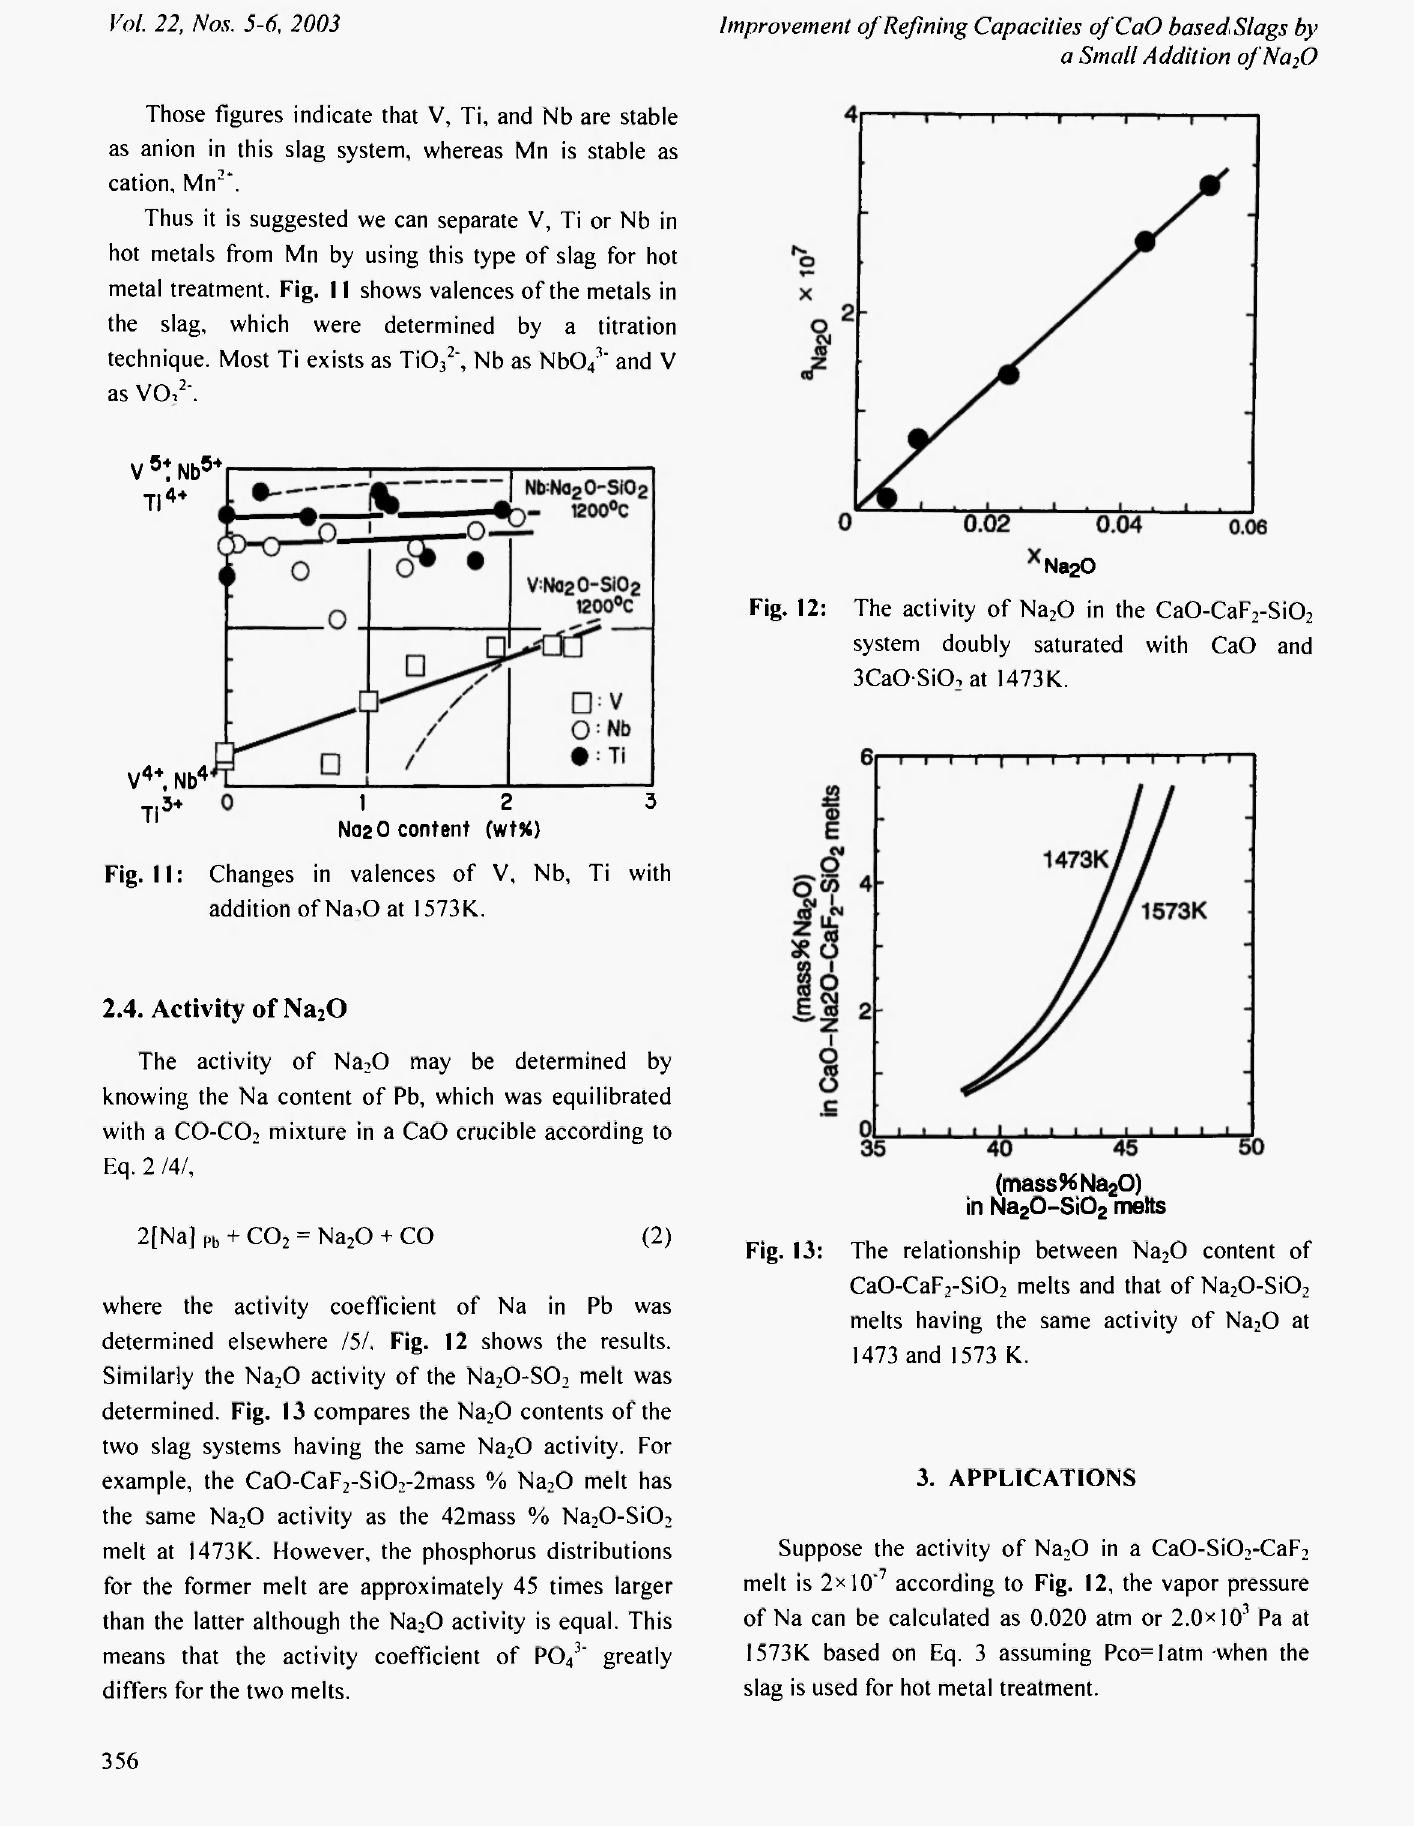
Fig. 13: The relationship between Na 2 0 content of Ca0-CaF 2 -Si0 2 melts and that of Na 2 0-Si0 2 melts having the same activity of Na 2 0 at 1473 and 1573